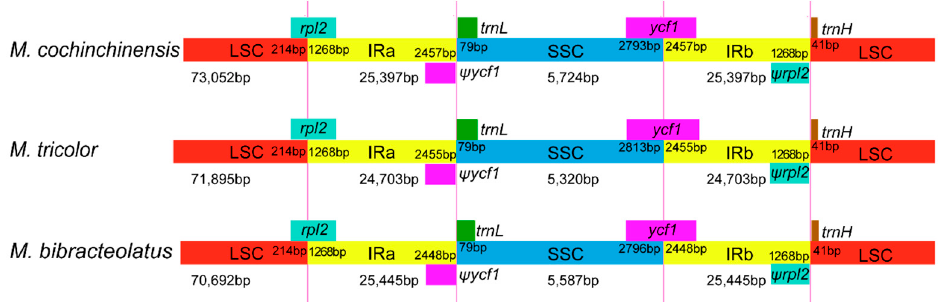
Figure 4. Comparison of the borders of the large single-copy (LSC), small single-copy (SSC), and inverted repeats (IR) regions among the chloroplast genomes of three Macrosolen species. The number above the gene features means the distance between the ends of genes and the borders sites. These features are not to scale. Ψ : pseudogenes.